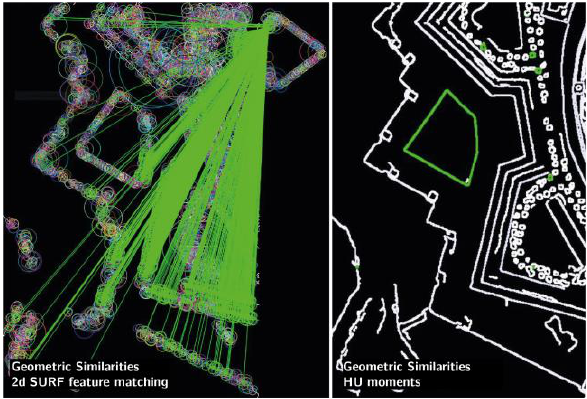
Figure 5. Geometric Similarities Evaluation Experiments green: matches between template and segmented geometry